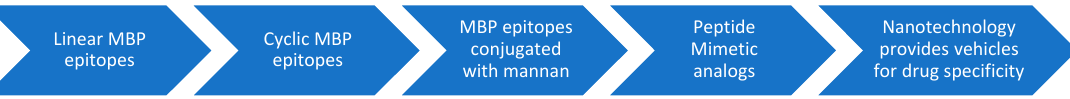
Figure 9. The road from linear epitope peptide to the therapeutic drug.